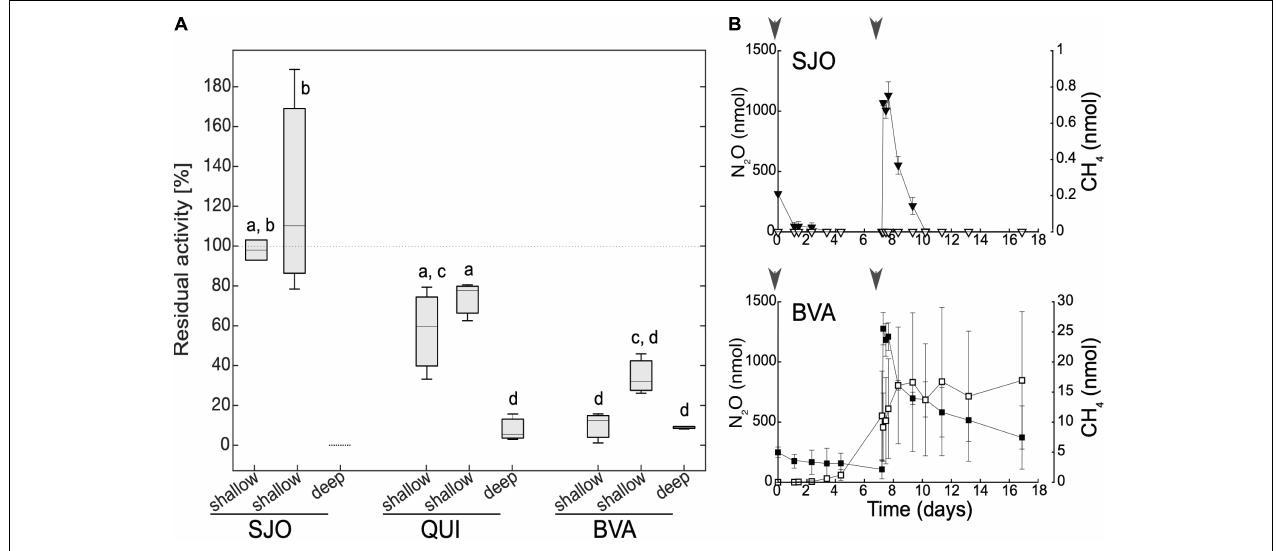
FIGURE 6 | Effect of NO 2 - amendment on methanogenic activity in peat soil incubated under anoxic conditions (A) and effect of N 2 O on enrichment cultures (B) . (A) For each site, two shallow (0–15 cm) and one deep (15–30 cm) soil slurry samples were incubated in triplicates. Residual activity denotes fractional CH 4 production relative to controls without additions. Dotted line for SJO’s deep soil denotes CH 4 levels below detection limit. Levels not reporting the same letter are significantly different (Student’s t -test, p = 0.05). (B) Nitrous oxide (full symbols) and CH 4 (open symbols) dynamics in enrichment cultures from SJO and BVA. Units are nmol per incubation vessel. Methane concentrations in SJO remained below detection throughout the illustrated incubation period. Gray arrowheads denote N 2 O addition time. Error bars represent one standard